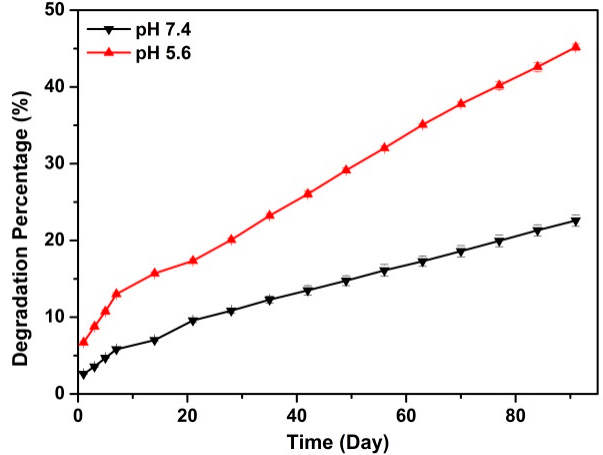
Figure 5. In vitro degradation profiles of Rod-CC NPs in phosphate-buffered saline (PBS) with different pH values.